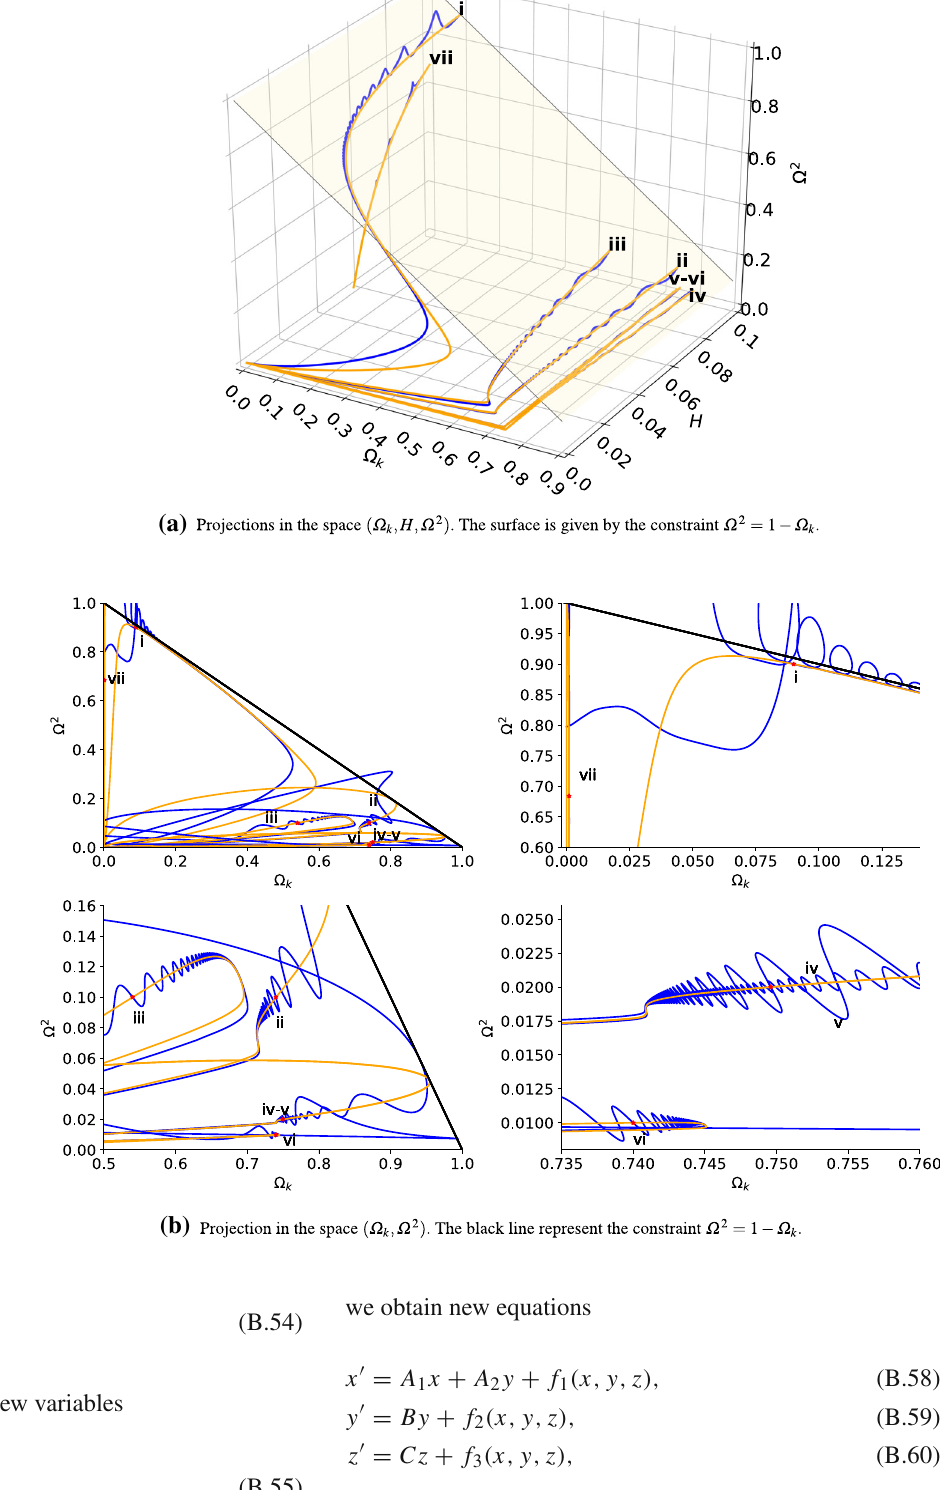
Fig. 14 Some solutions of the full system (46) (blue) and time-averaged system (78) (orange) for the LRS Bianchi III metric when γ = 0, in the projection Σ = 0. We have used for both systems initial data sets presented in the Table